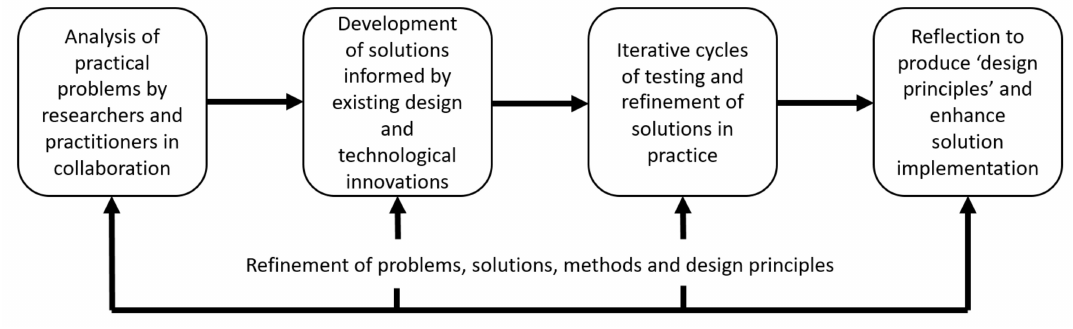
Figure 5. Design-Based Research using Reeves’ [42] (p. 59)